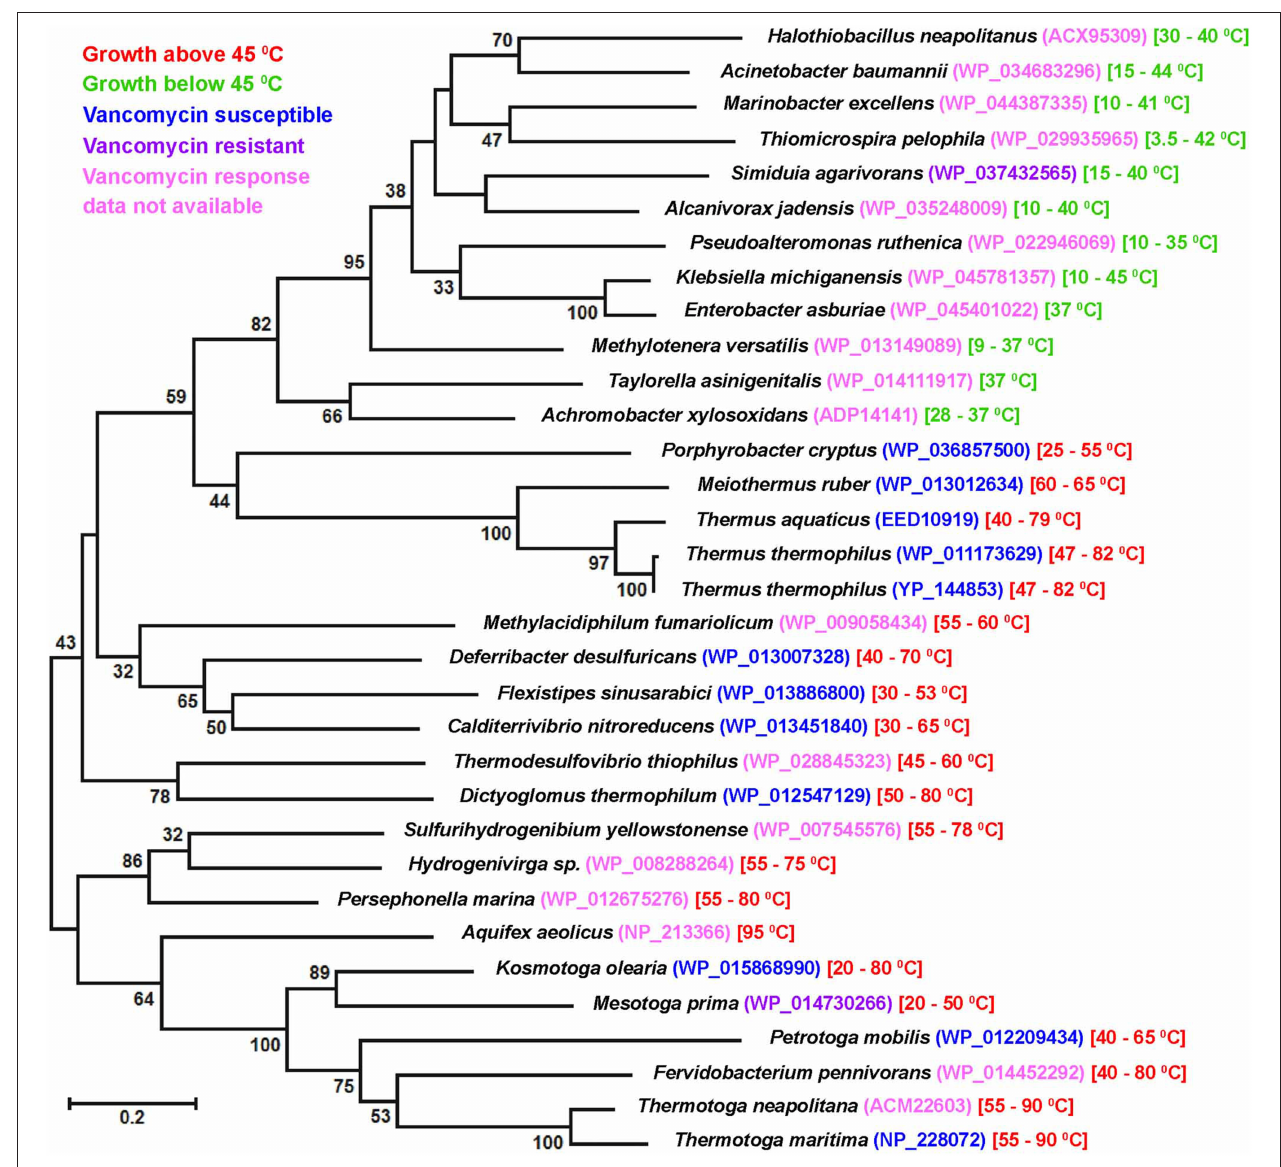
FIGURE 2 | Maximum likelihood tree constructed with D-alanine-D-alanine ligase (Ddl) sequences of Gram-negative thermophilic as well as mesophilic bacteria. Growth temperature range of a given species is mentioned following the protein IDs of the Ddl homologs. Bootstrap support > 30 (among 100 replicates) are given at the nodes. The scale bar represents two substitutions per 100 sites for a unit branch